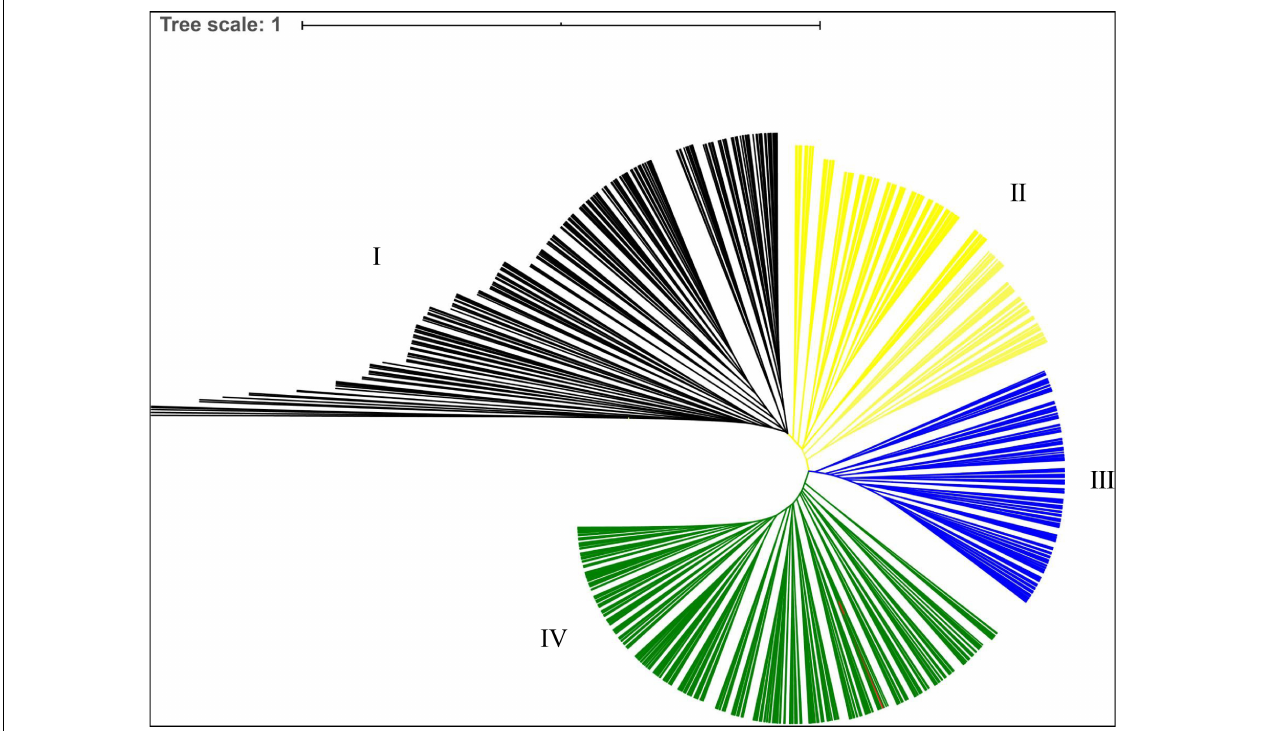
FIGURE 1 | Phylogenetic tree of the 955 A. trifoliate accessions based on genetic distance. Blue and orange indicate different clusters.